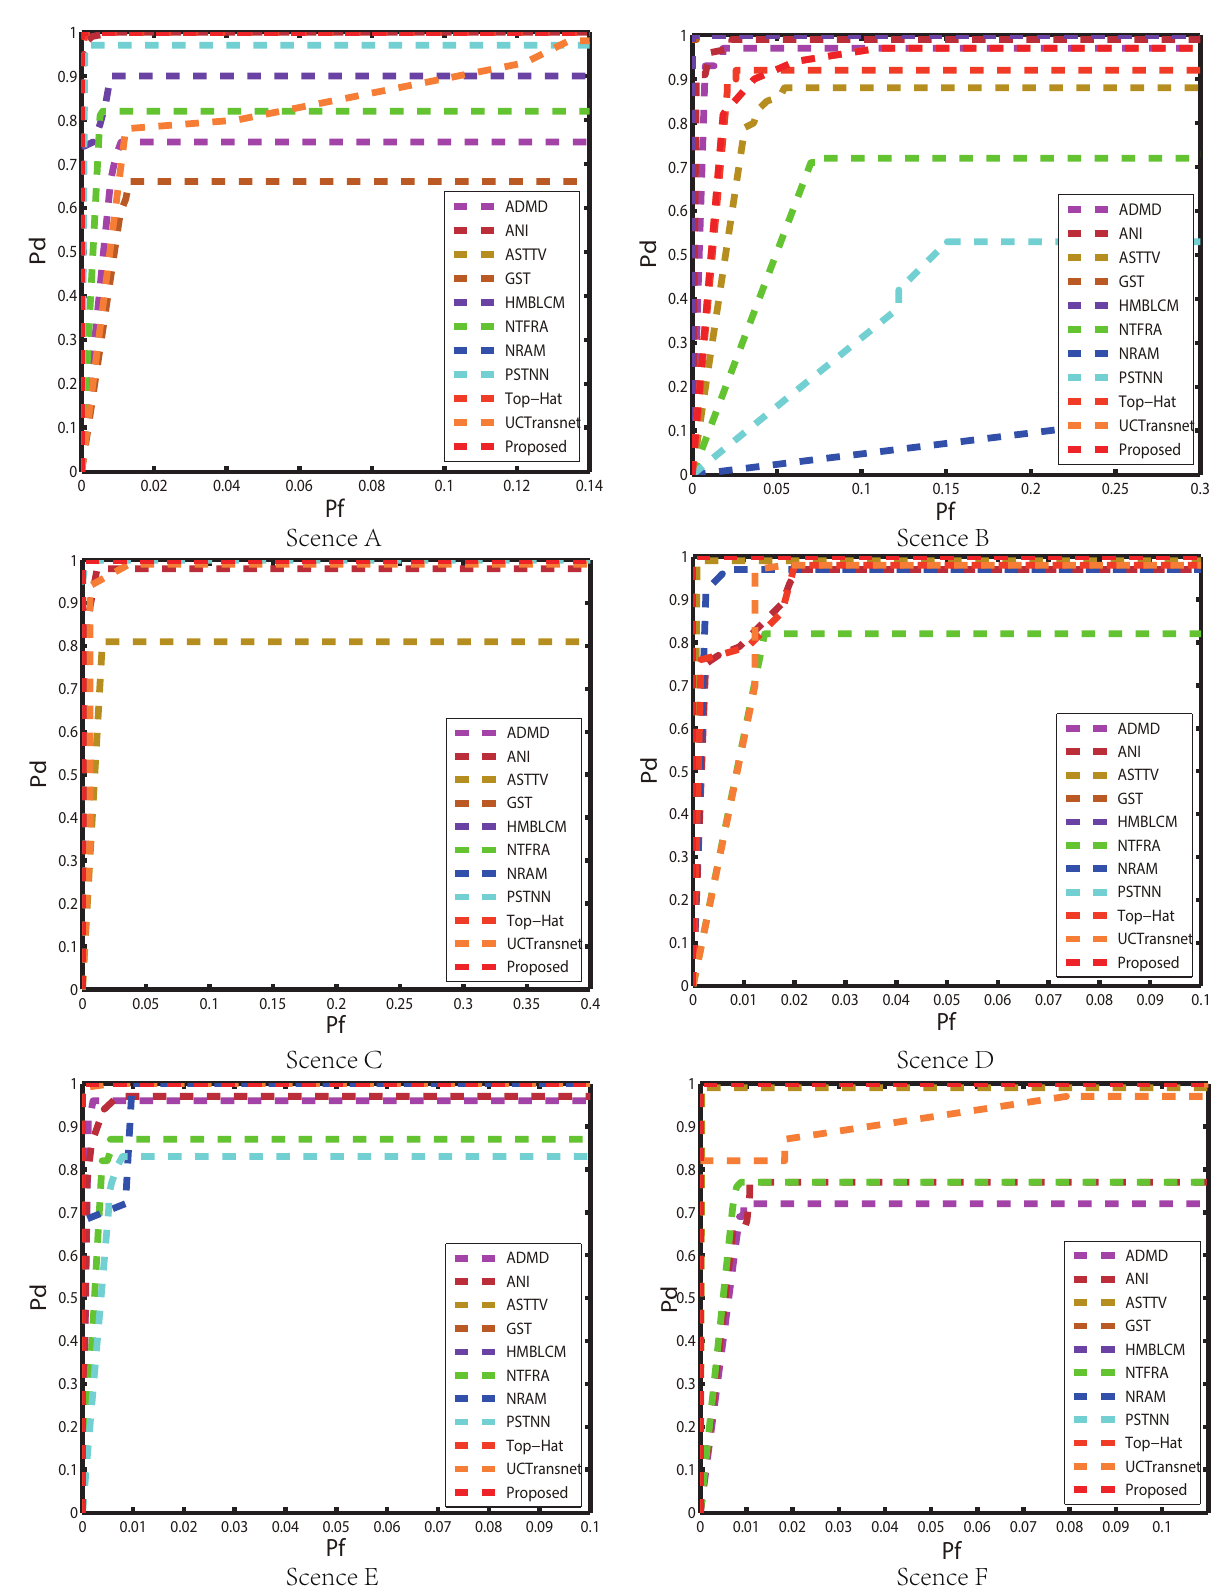
Figure 19. Schematic of ROC curves for 10 model detection models in 6 sequence